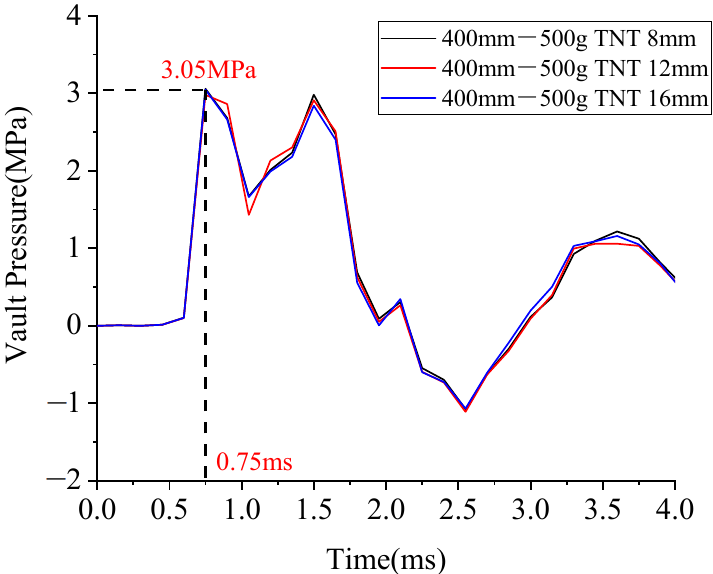
Figure 9. Pressure on the arch vault under a standoff distance of 0.4 m and an amount of TNT of 0.5 kg.